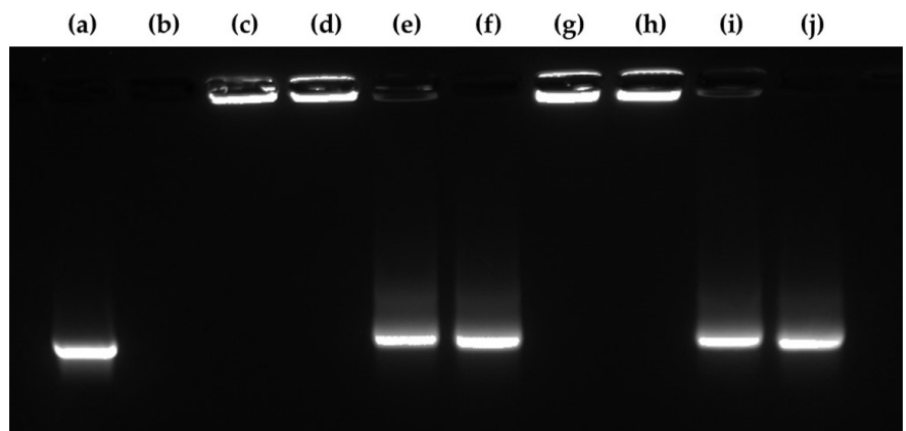
Figure 7. Electrophoretic analysis of naked mRNA and the mRNA/PEI8/ γ -PGA12 complex fol- lowing RNase treatment. The mRNA was visualized using GelRed. Heparin sulfate was added to the samples to evaluate the effect of complex dissociation. ( a ) Naked mRNA, ( b ) naked mRNA incubated with RNase, ( c ) mRNA/PEI8 complex, ( d ) mRNA/PEI8 complex incubated with RNase, ( e ) mRNA/PEI8 complex to which heparin was added, ( f ) mRNA/PEI8 complex incubated with RNase and to which heparin was added, ( g ) mRNA/PEI8/ γ -PGA12 complex, ( h ) mRNA/PEI8/ γ -PGA12 complex incubated with RNase, ( i ) mRNA/PEI8/ γ -PGA12 complex to which heparin was added, ( j ) mRNA/PEI8 γ -PGA12 complex incubated with RNase and to which heparin was added.